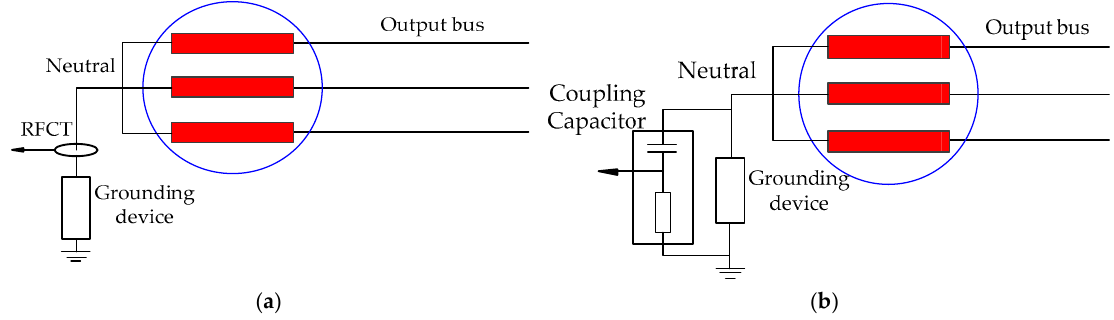
Figure 5. Neutral detection methods ( a ) Coupled by RFCT; ( b ) Coupled by coupling capacitor [44].